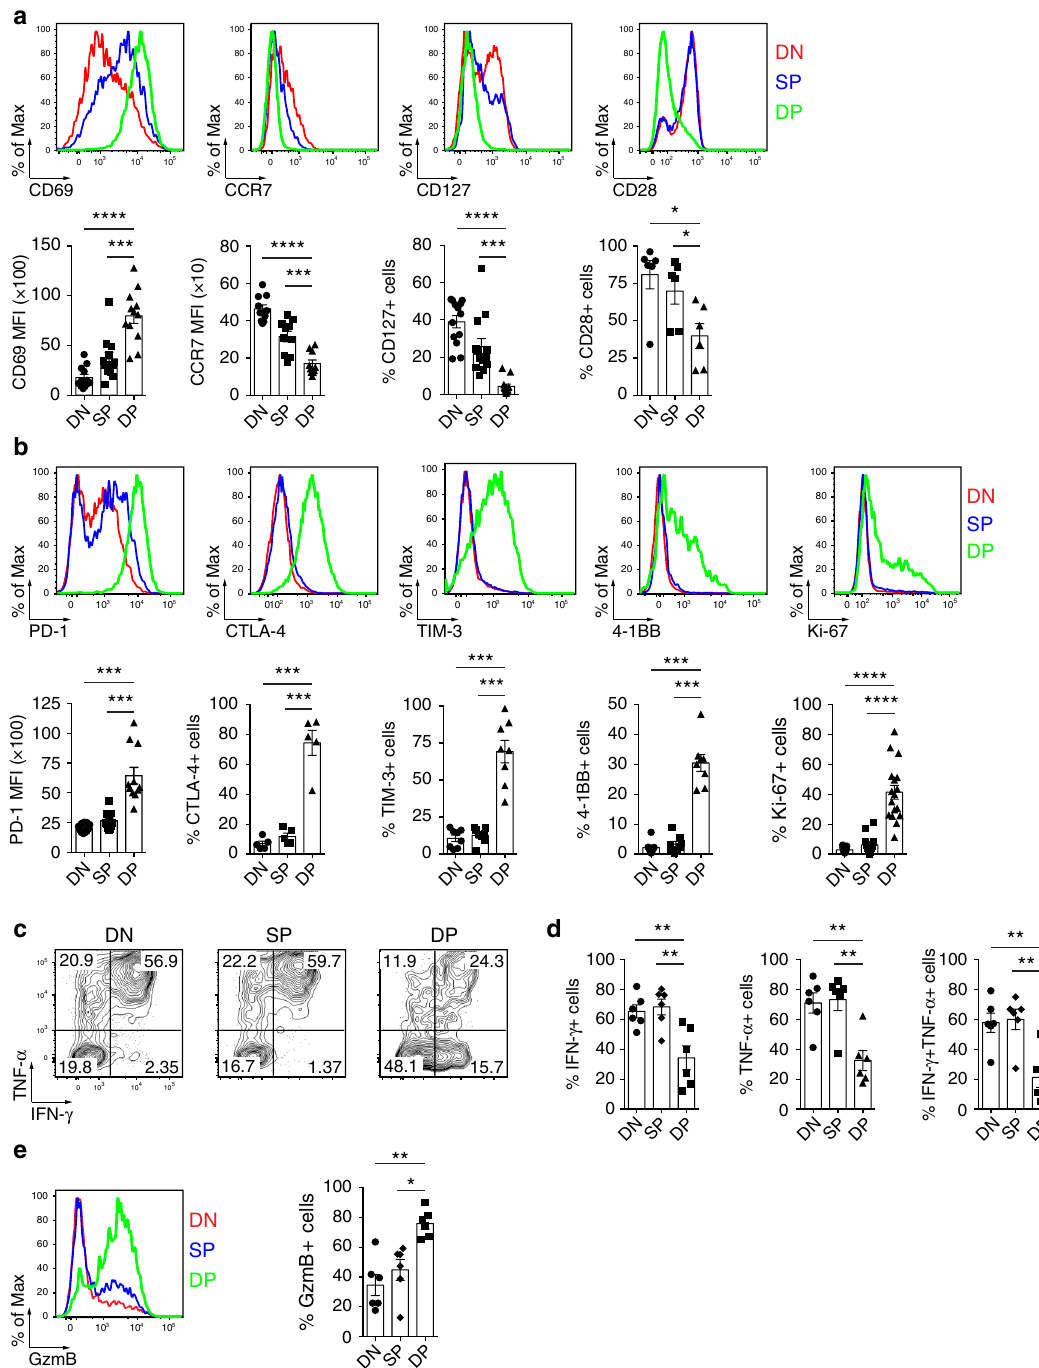
Fig. 3 Phenotypic and functional properties of DP, SP and DN CD8 TILs. a Ex vivo phenotypic analysis of the expression of surface proteins CD69, CCR7, CD127, and CD28, delineating a T RM phenotype, on the three CD8 TIL subsets (top, one representative patient shown, colors match key). Summary of the frequency/expression level of the above-mentioned markers among several cancer patients ( n = 12 for CD69; n = 10 for CCR7; n = 13 for CD127; and n = 6 for CD28, bottom). Each dot represents one patient. b Ex vivo phenotypic analysis of the expression of surface and intracellular proteins PD-1, CTLA-4, TIM-3, 4-1BB, and Ki-67, delineating an activated/chronically stimulated phenotype, on the three CD8 TIL subsets (top, one representative patient shown, colors match key). Summary of the frequency of the above-mentioned markers among several cancer patients ( n = 11 for PD-1; n = 5 for CTLA-4; n = 8 for TIM-3; n = 8 for 4-1BB; and n = 17 for Ki-67, bottom). Each dot represents one patient. c Representative fl ow cytometric analysis of IFN- γ and TNF- α production by the three CD8 TIL subsets stimulated for 4 h with Phorbol 12-Myristate 13-Acetate (PMA)/ionomycin. Numbers in each quadrant indicate percent cells positive for IFN- γ and/or TNF- α for each subset. d Frequency of IFN- γ , TNF- α , IFN- γ /TNF- α double-positive cells by each CD8 TIL subsets. Data are from 6 HNSCC patients. e Representative fl ow cytometric analysis of granzyme B production by CD8 TIL subsets (left, colors match key) and summary of six different HNSCC patients (right). Small horizontal lines indicate mean ± SEM; * p < 0.05; ** p < 0.01; *** p < 0.001; **** p < 0.0001; p -values were determined by one-way analysis of variance with Tukey ’ s post hoc testing ( a , b , d , e